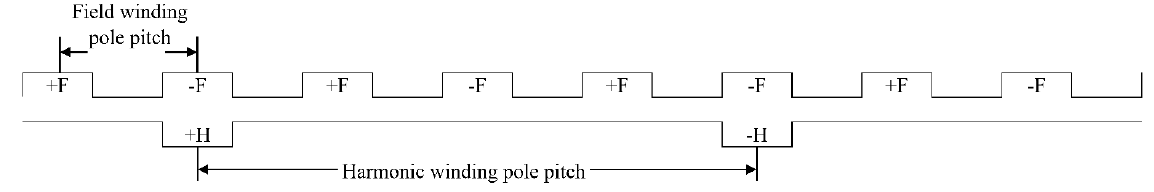
Figure 2. Machine layout for the proposed SHSM.